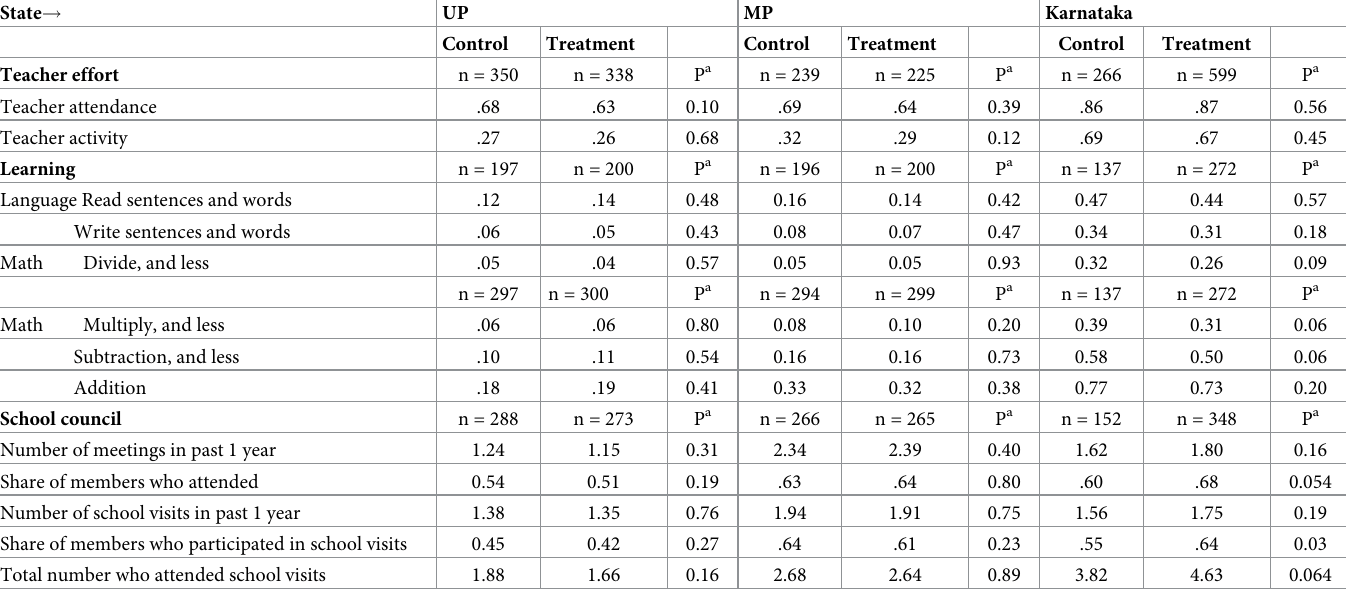
Table 1. Baseline outcomes by randomized treatment status in MP, UP and Karnataka.